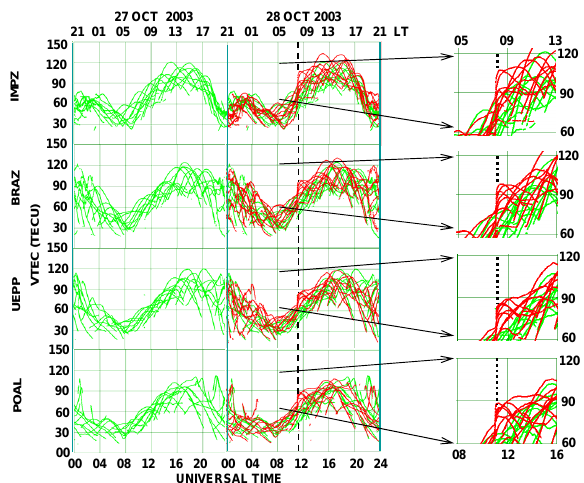
Fig. 3. Vertical total electron content (VTEC) observed at Imper- atriz (IMPZ), Bras´ılia (BRAZ), Presidente Prudente (UEPP), and Porto Alegre (POAL) stations (Table 1) on UT days 27 (green lines) and 28 (red lines) October 2003. A blowup of the VTEC data near the flare time is shown on the right-hand side.